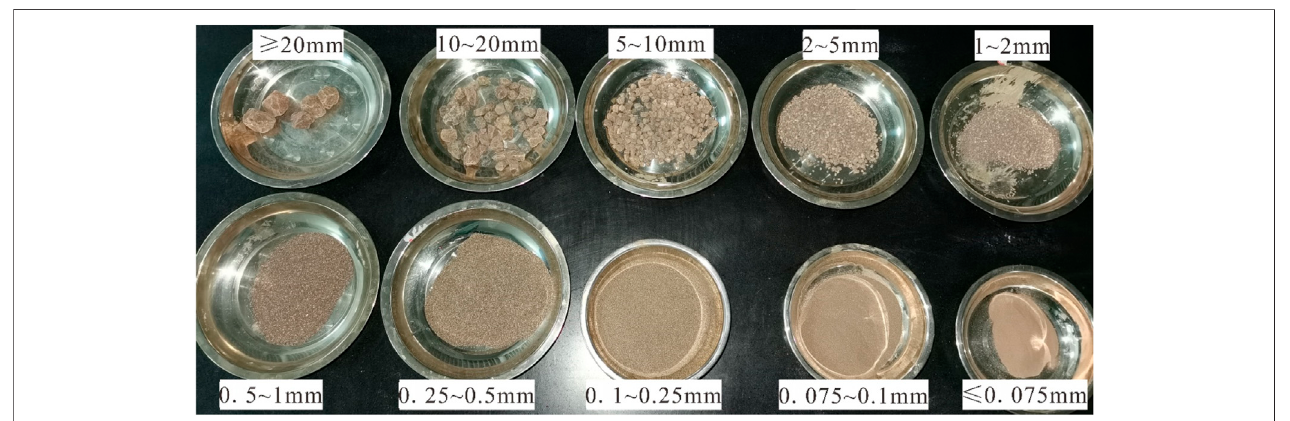
FIGURE 4 | Sieving results of S-RMs.